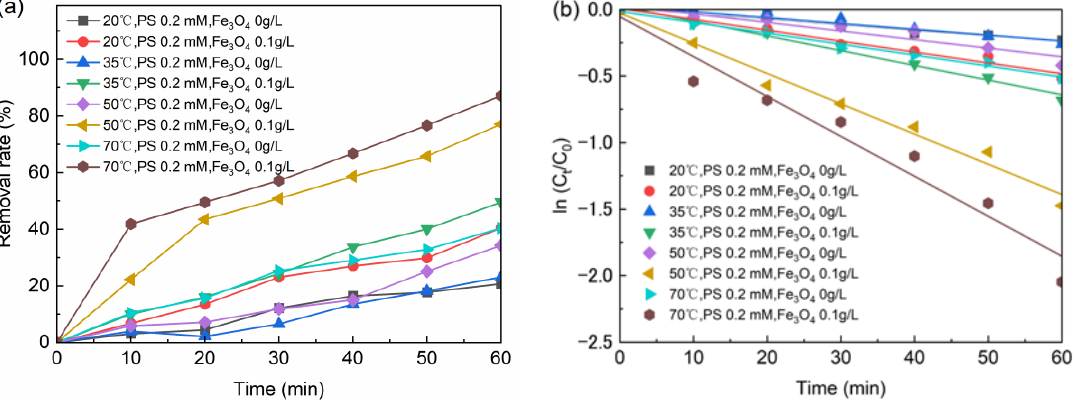
equation (Table 4).